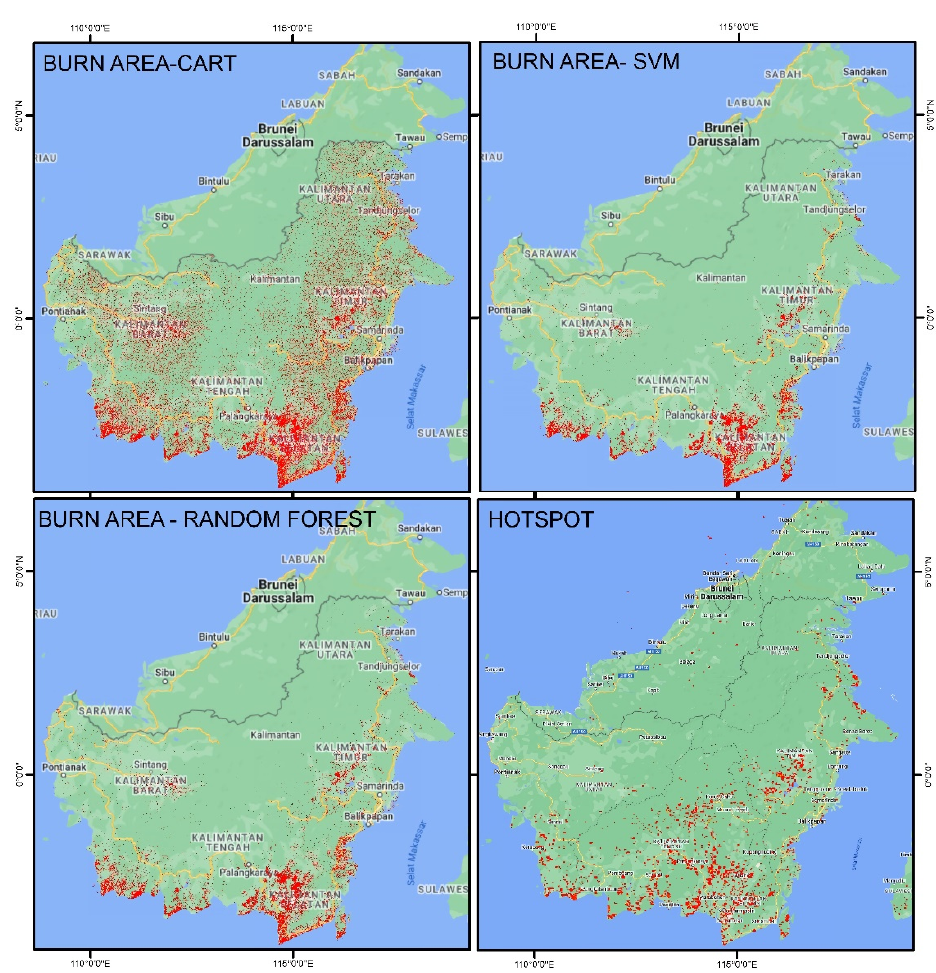
Figure 7. The difference in the burn area of the three types of classifiers, compared to the Hotspot